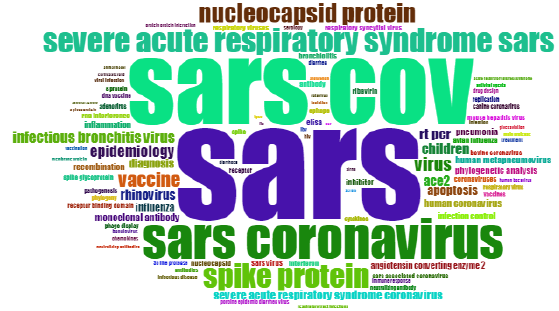
Figure 3. Keywords cloud map of 2004 – 2007.